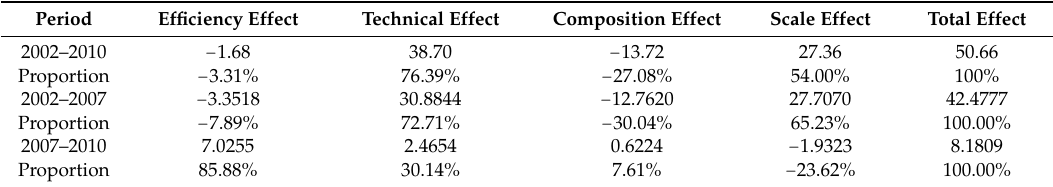
Table 7. Structural decomposition results of embodied carbon flowed in Beijing (million